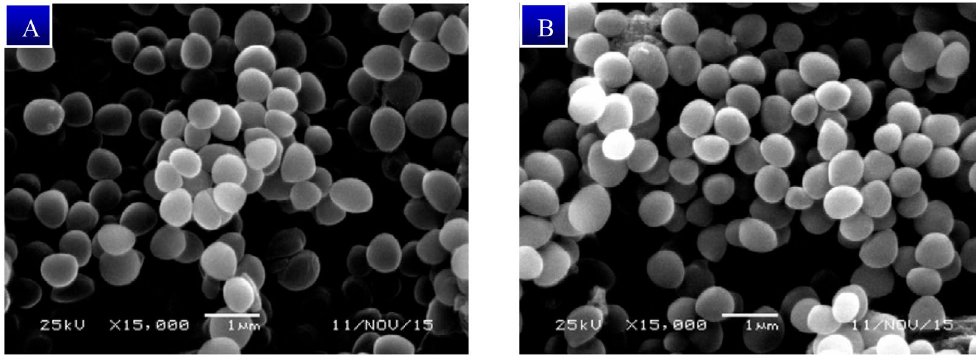
Figure 6. Scanning electron microscopy showed that callistemenonone A ( 1 ) induced no cell lysis and membrane disruption. ( A ) MRSA (JCSC 2172) incubated with callistemenonone A ( 1 ) (160 μ g/mL, 8 × MIC) after 4 h; ( B ) Untreated MRSA (JCSC